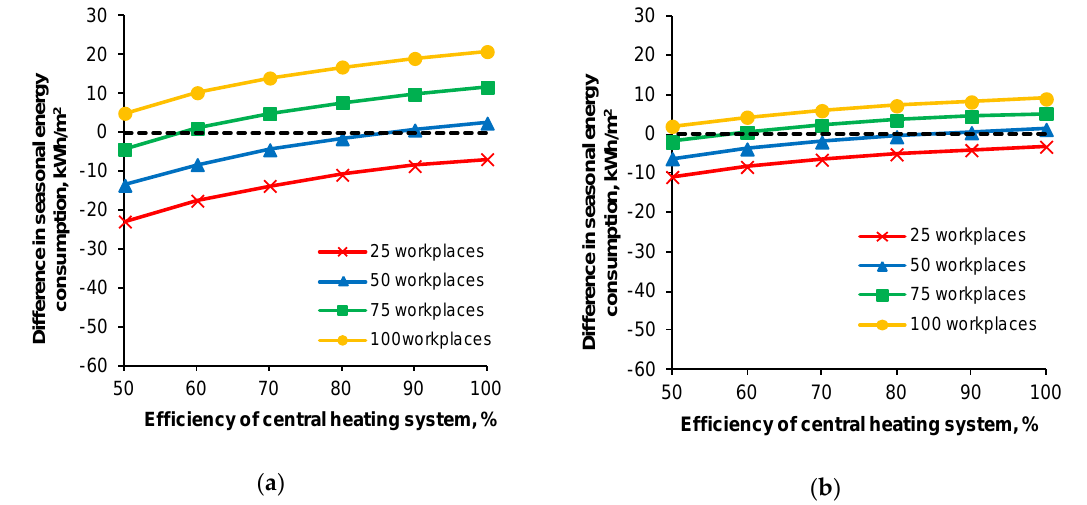
Figure 8. Difference in the seasonal additional energy consumption for workplaces heating from 18 °C to a comfort temperature with a local system in comparison to a central system for two internal heat gains variants: 10 ( a ) and 50 W/m 2 ( b ).